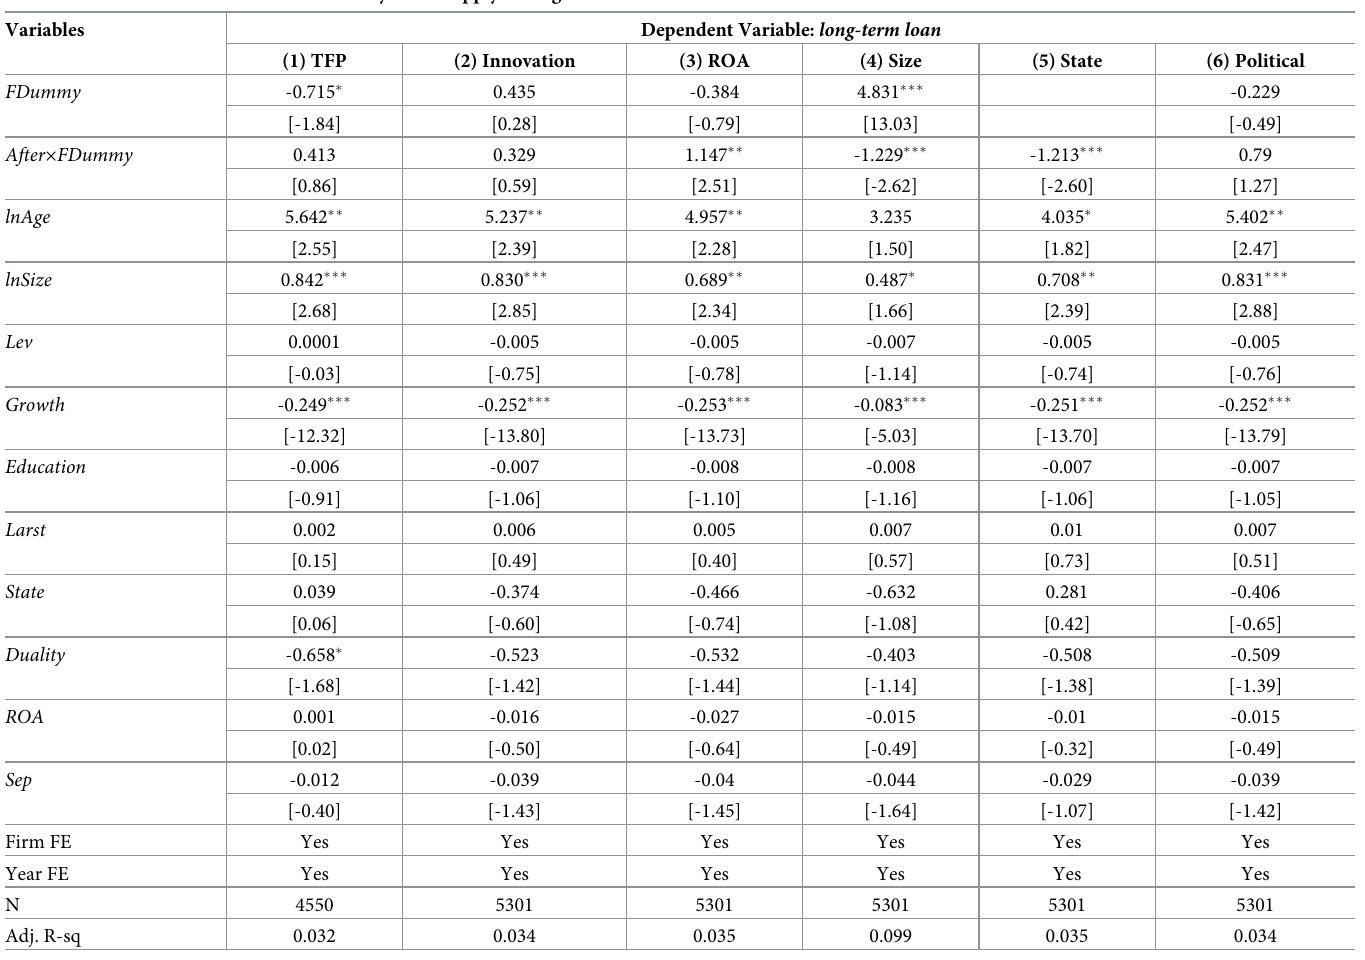
Table 3. Effects of EPTL2016 on the efficiency of the supply of long-term loans. Variables